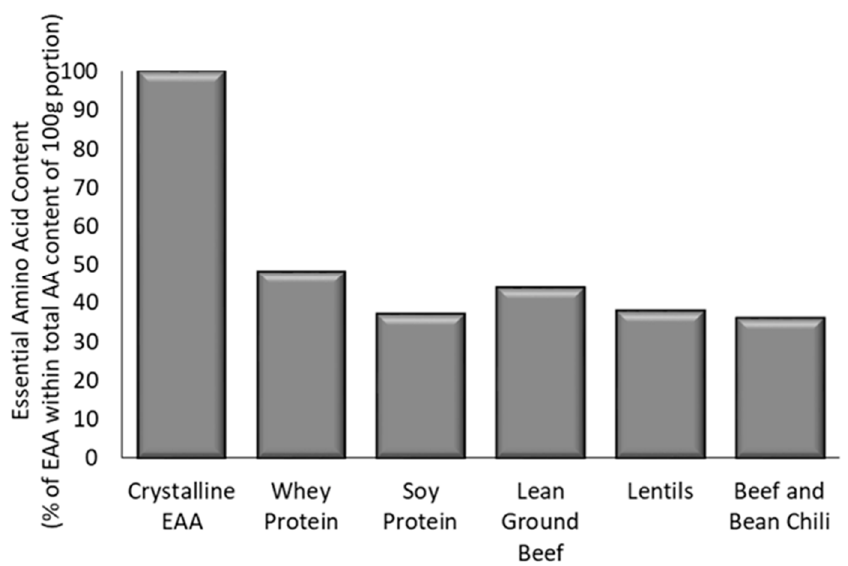
Figure 3. Relative essential amino acid content of free-form essential amino acids, various intact proteins, and a protein-containing mixed meal.